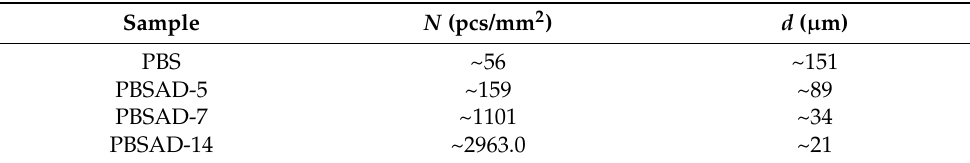
Table 3. Nucleation densities ( N ) and average spherulite diameters ( d ) of PBS and PBSAD. Sample